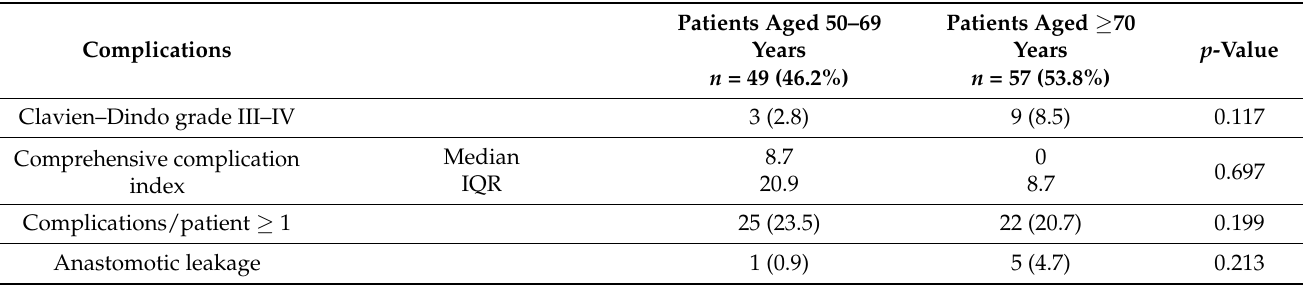
Table 3. Details of postoperative complications by age